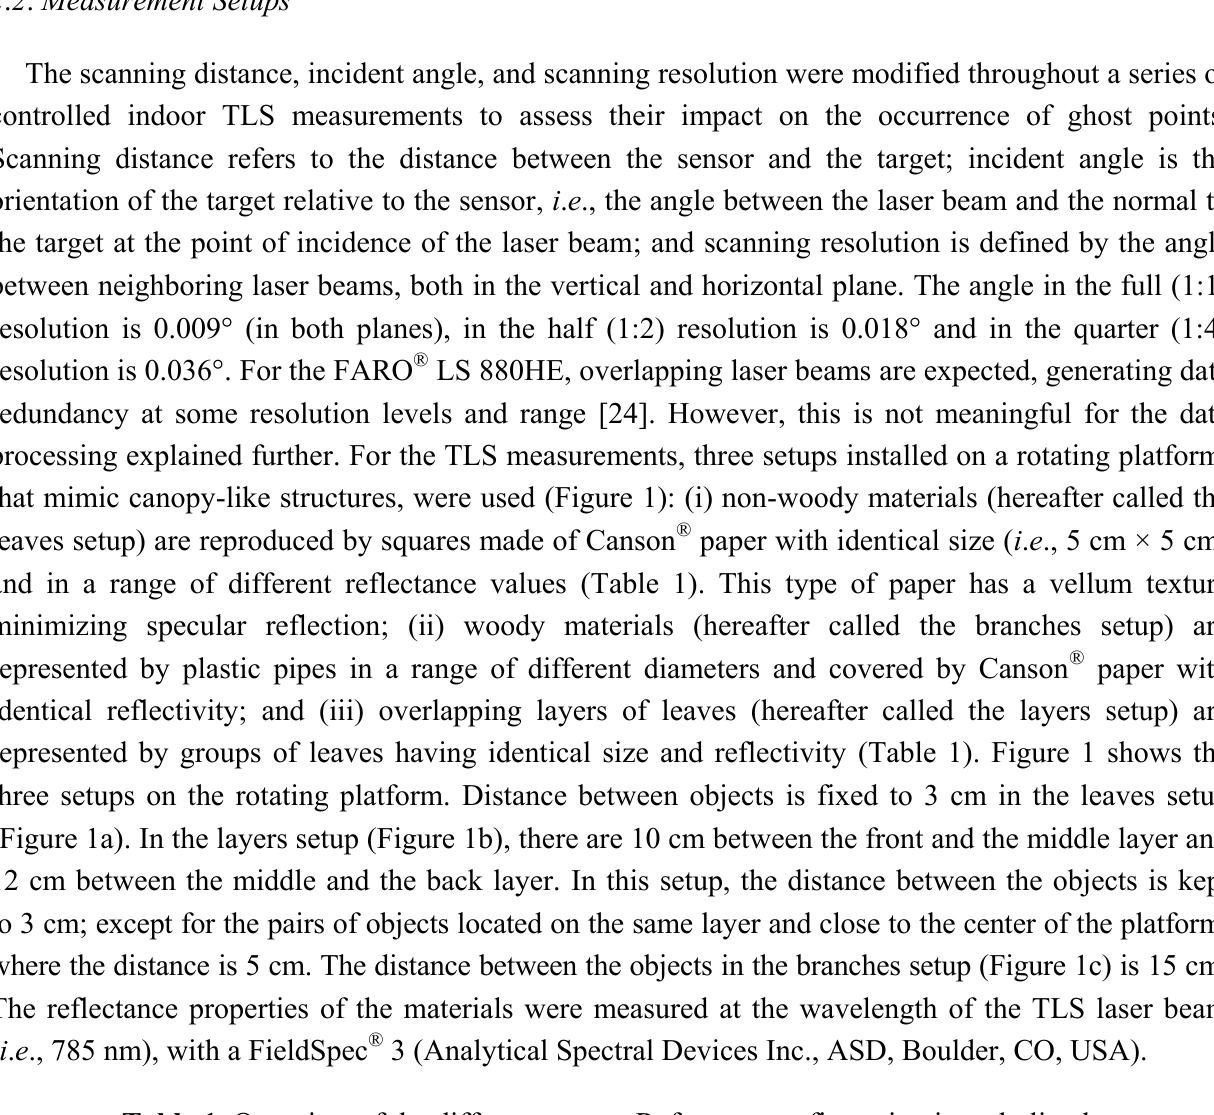
Table 1. Overview of the different setups. Reference configuration is